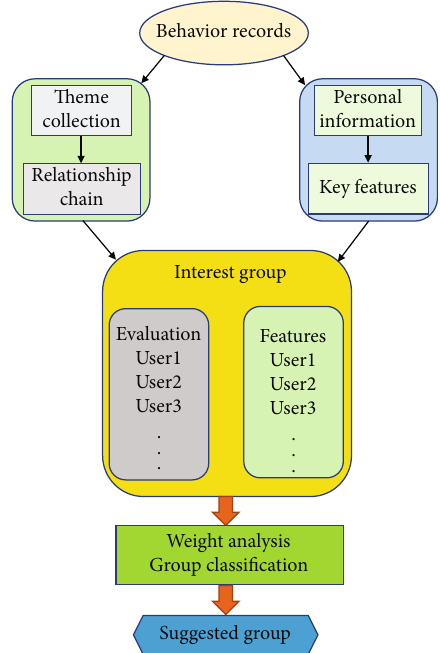
Figure 5: The CF algorithm fl ow adopted by the user group interest